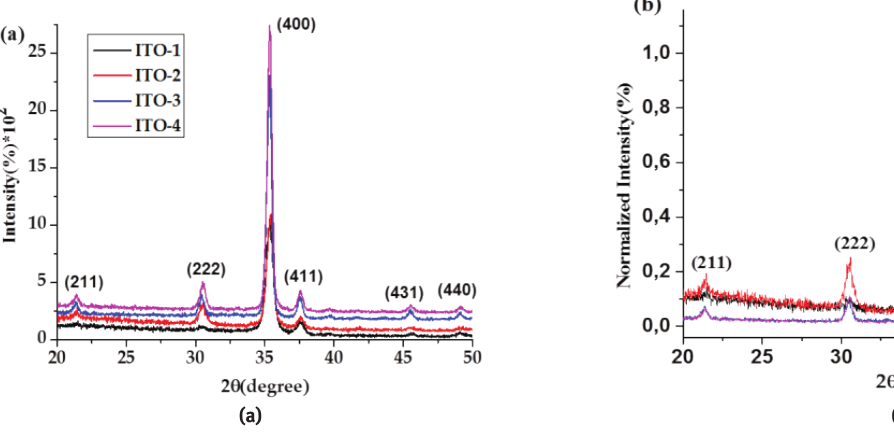
Figure 2: XPS graphs (a) Ti 2p (b) O 1s of as-deposited p-TiO Fig 2. XPS graphs (a) Ti 2p (b) O 1s of as-deposited p-TiO